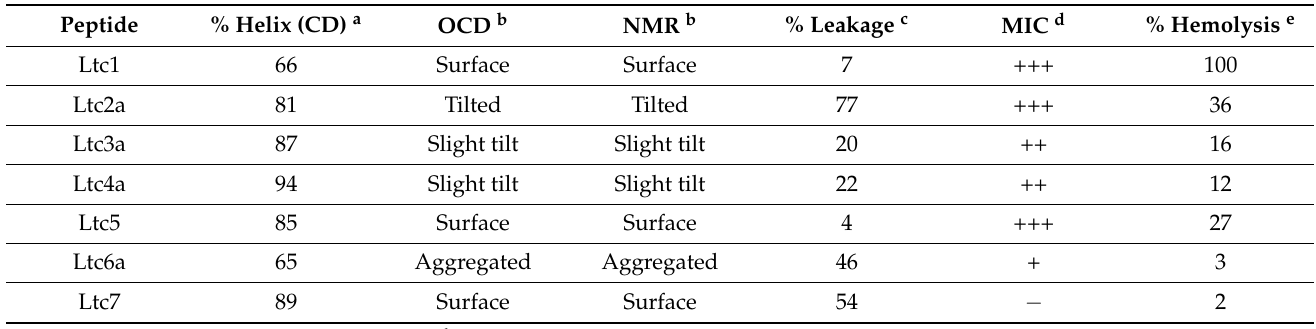
Table 2. A summary of the biophysical and biological data of